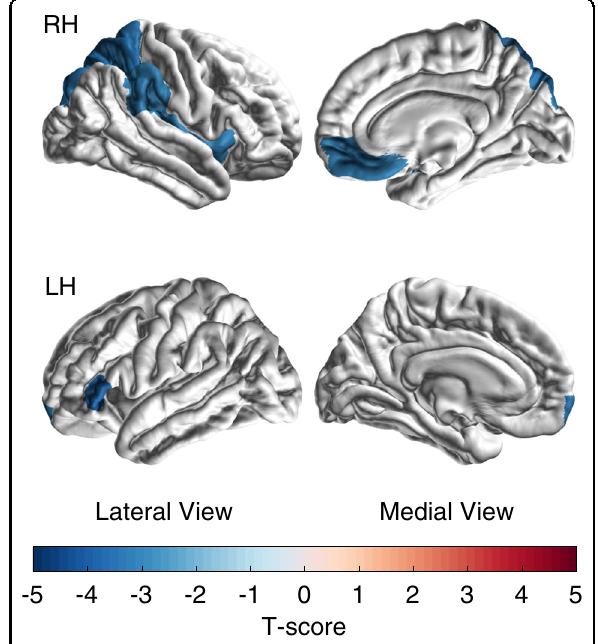
Fig. 1 T -scores for brain regions that show a signi fi cant ( p corrected < 0.05) decreased surface area associated with higher insomnia severity scores in major depressive disorder patients. Models are adjusted for age, sex, insomnia-independent depression severity (HDRS-14) and site. RH right hemisphere, LF left